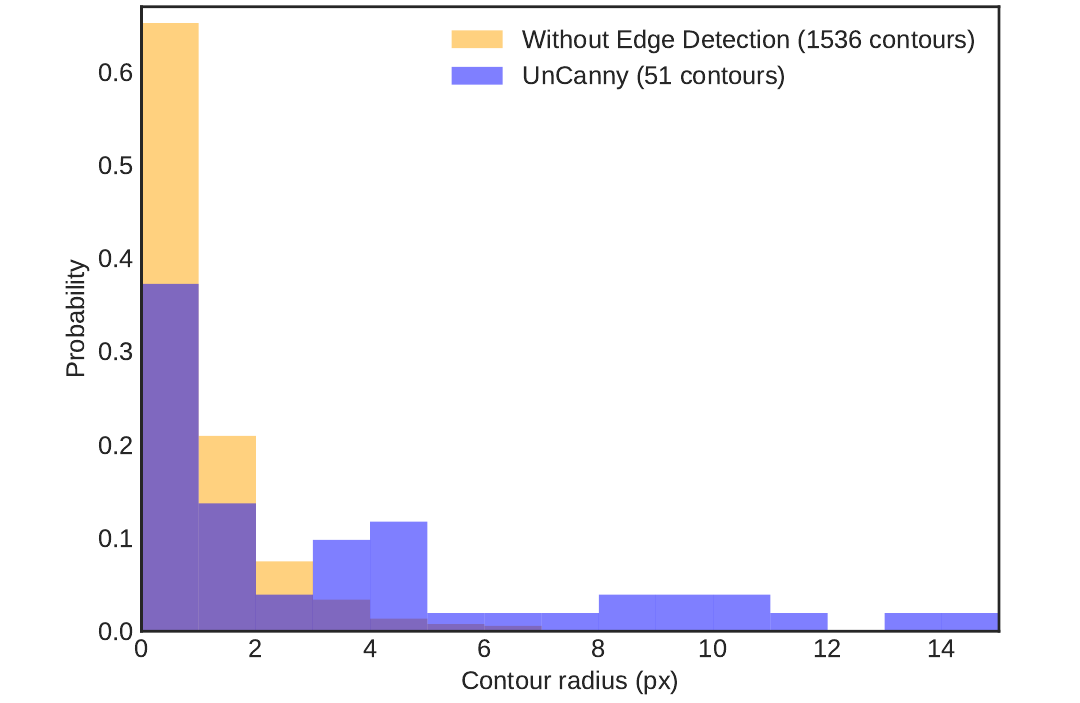
Figure 5. This is a normalized histogram of contour radii detected in the nocturnal bird migration video. Bins were set at 1px width. Image processing including blurring, subtraction, and thinning steps, but excluding edge detection reported 1536 contours. The UnCanny method, which includes the edge detection step, reported 51 contours over 34.46s of the same input video. The proportion skews toward larger radii in the UnCanny filter, likely due to the high levels of visual noise in the reduced method, diluting “hits.”